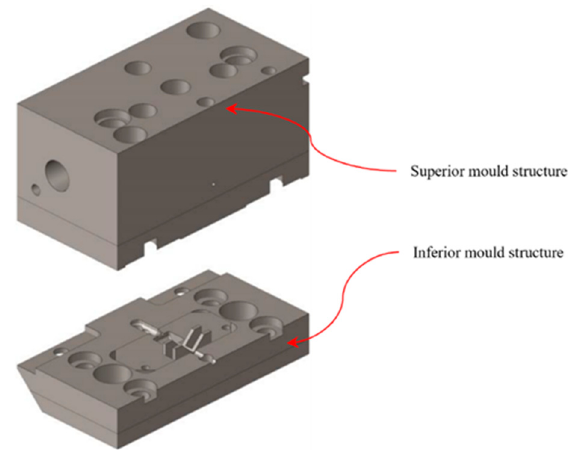
Figure 11. Geometry of the improved mold structure.